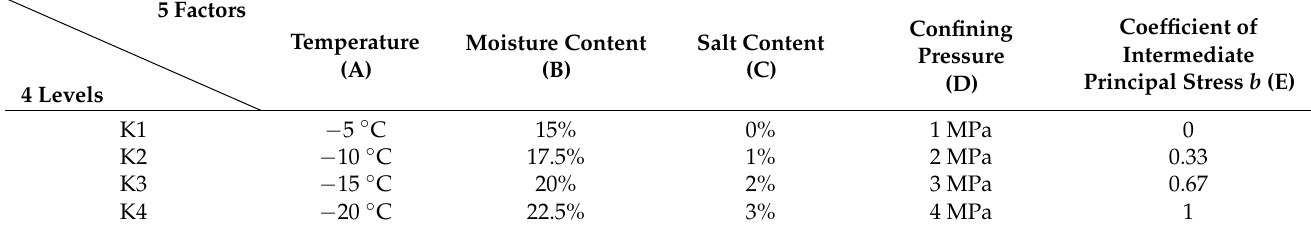
Table 2. Levels of calcareous clay factors considered in true triaxial test.